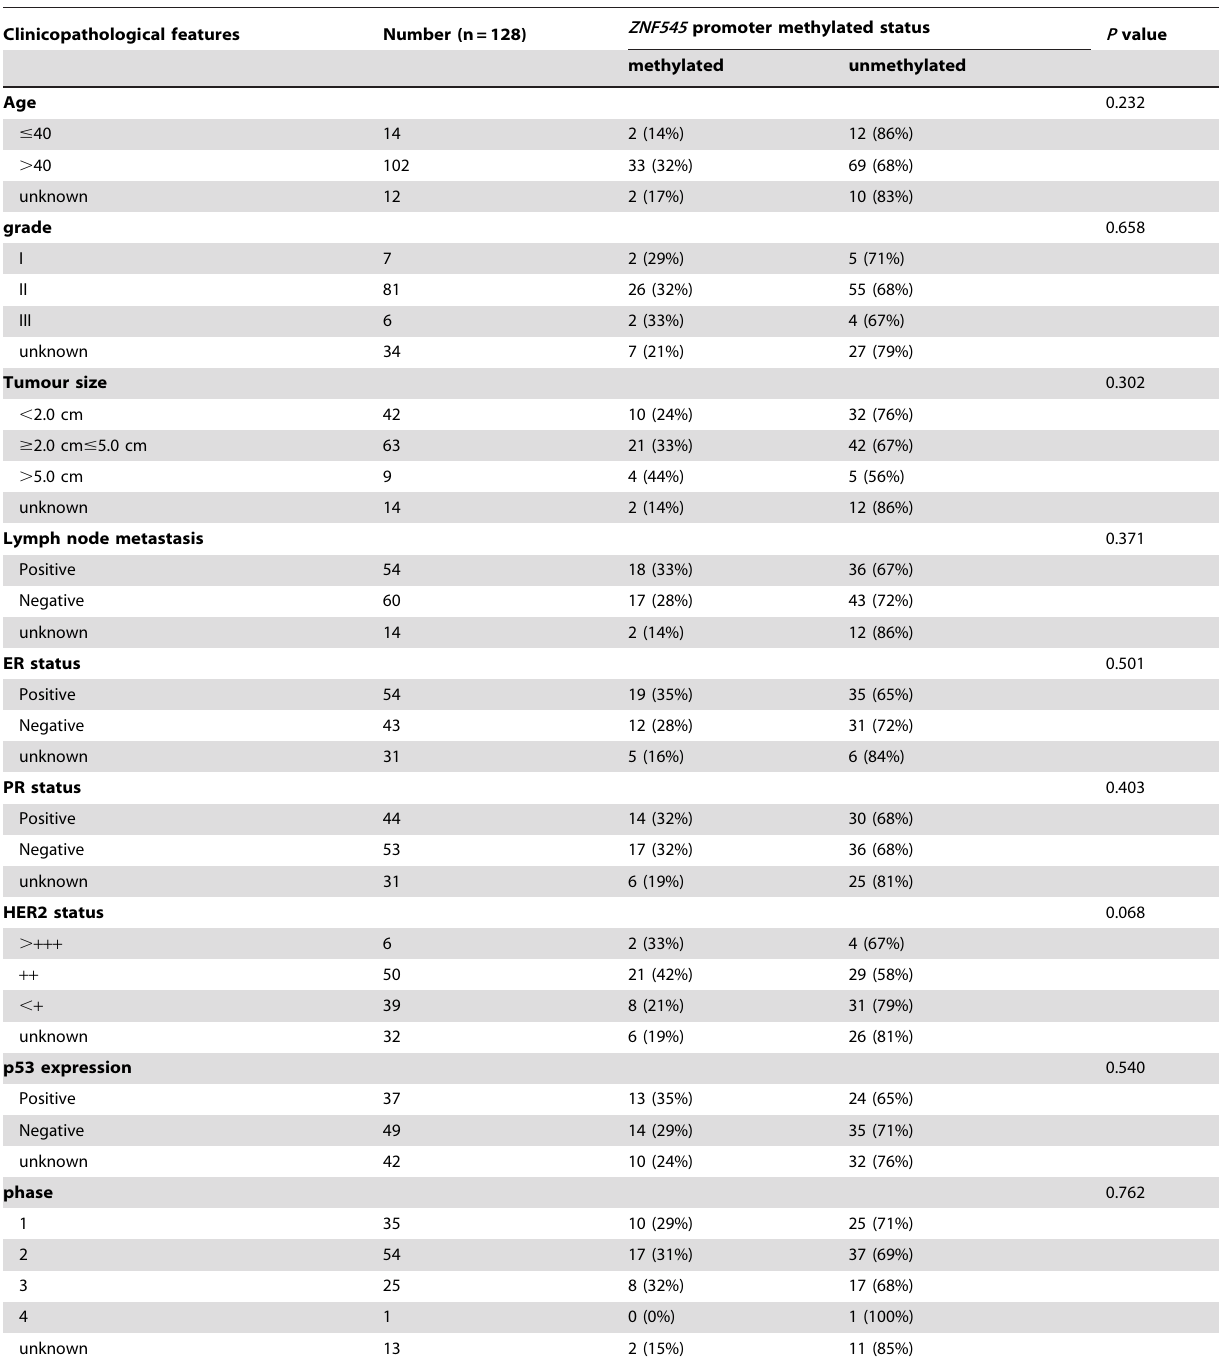
Table 1. ZNF545 methylation and clinicopathologic features of breast tumors.